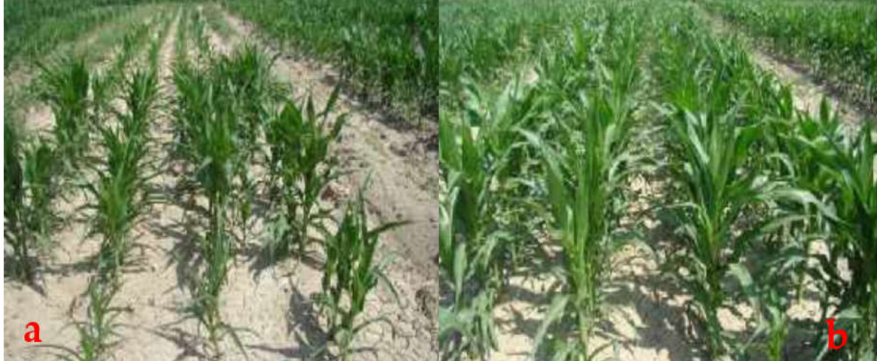
Figure 4. Effect of tractor wheeling on plant biomass ( a ) trafficked and ( b ) non-trafficked experimental plots